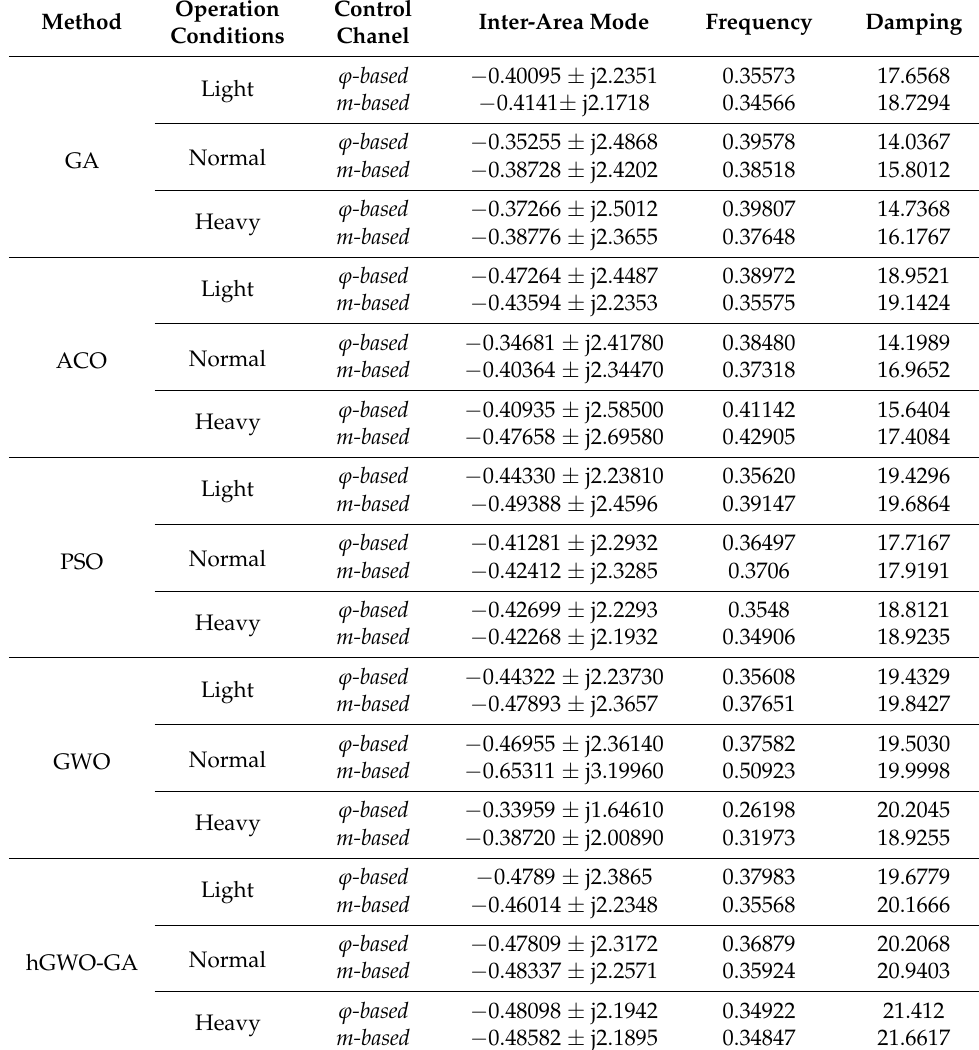
Table 5. Inter-area mode for the closed-loop system in optimal